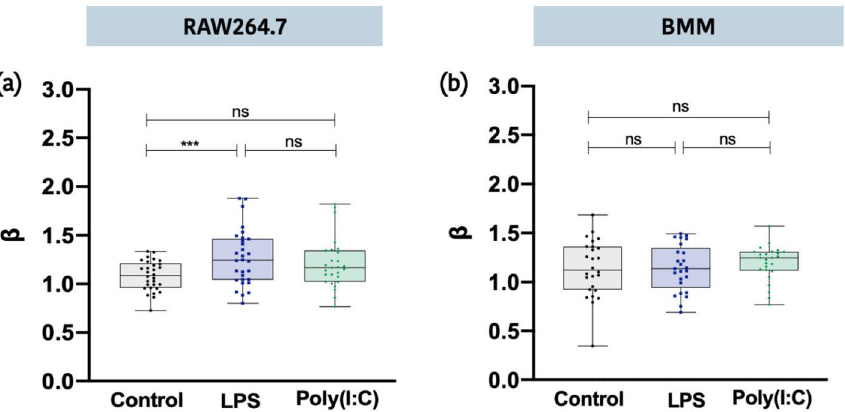
Figure 5. PSD analysis of NAD(P)H-TPEF images to evaluate mitochondrial organization. β values determined from the slope of the power law fit of the radially averaged PSD as a function of spatial frequency of NAD(P) H-TPEF full field images for ( a ) RAW264.7 cells and ( b ) BMM cells (*p ≤ 0.05, **p ≤ 0.01, ***p ≤ 0.001, ****p ≤